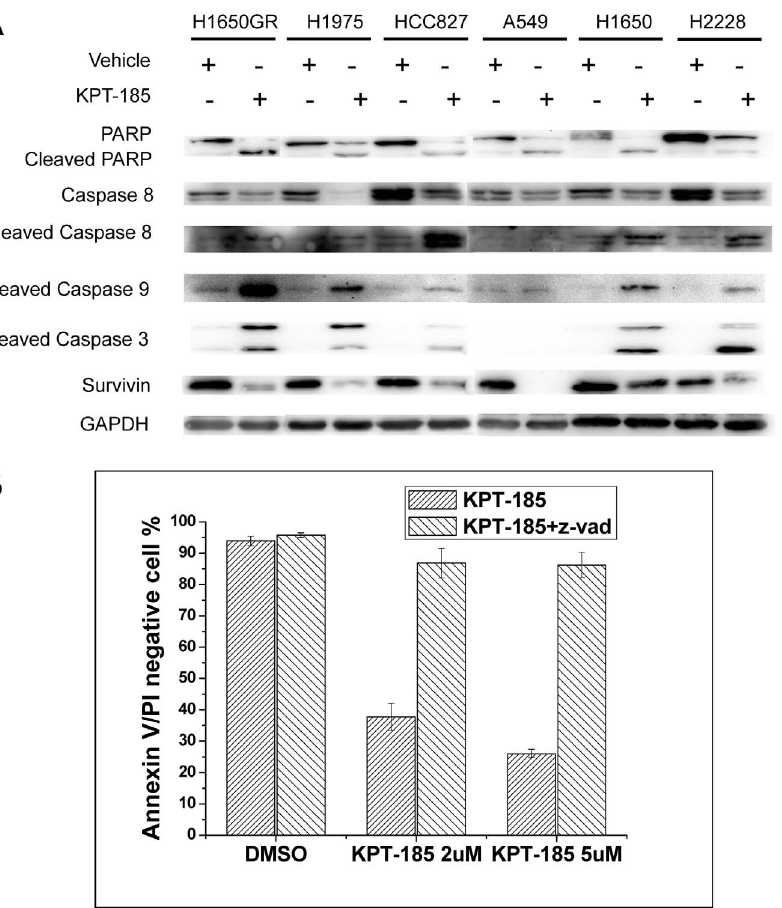
Figure 5. Effect of KPT-185 on the regulation of apoptosis related protein expression in NSCLC cells. The six NSCLC cell lines were treated with KPT-185 for 48 h. Caspases-8, -9 and -3 and PARP were activated or cleaved, but survivin was down-regulated (A). In the presence of the pan-caspase inhibitor Z-VAD-FMK, KPT-185-induced apoptosis was completely blocked in H1975 cells (B, N=3).